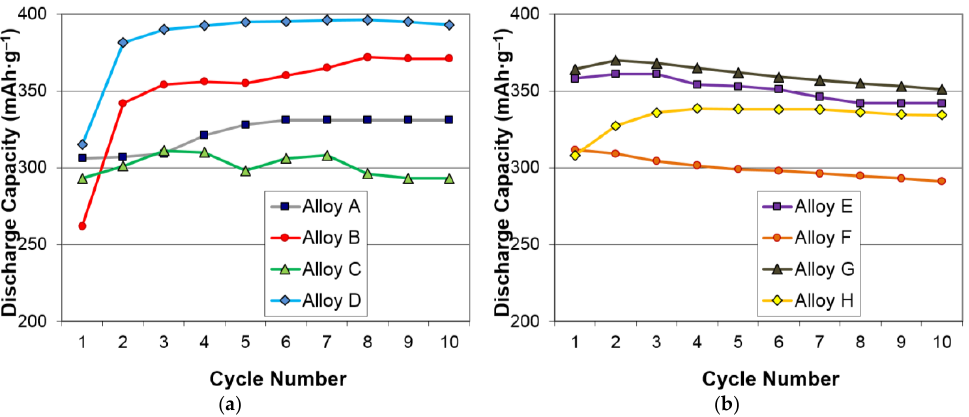
Figure 2. Electrochemical full-capacity activation behavior for as-is alloys ( a ) A – D and ( b ) E – H . Table 1. Preparation and properties of alloys used in this study. Low-rate discharge capacity and saturated magnetic susceptibility ( M s ) are in the units of mAh·g ‒1 and emu·g ‒1 , respectively. HRDs are the ratio of capacities between 50 and 4 mA·g ‒1 for B – D and capacities between 100 and 8 mA·g ‒1 for all other alloys.